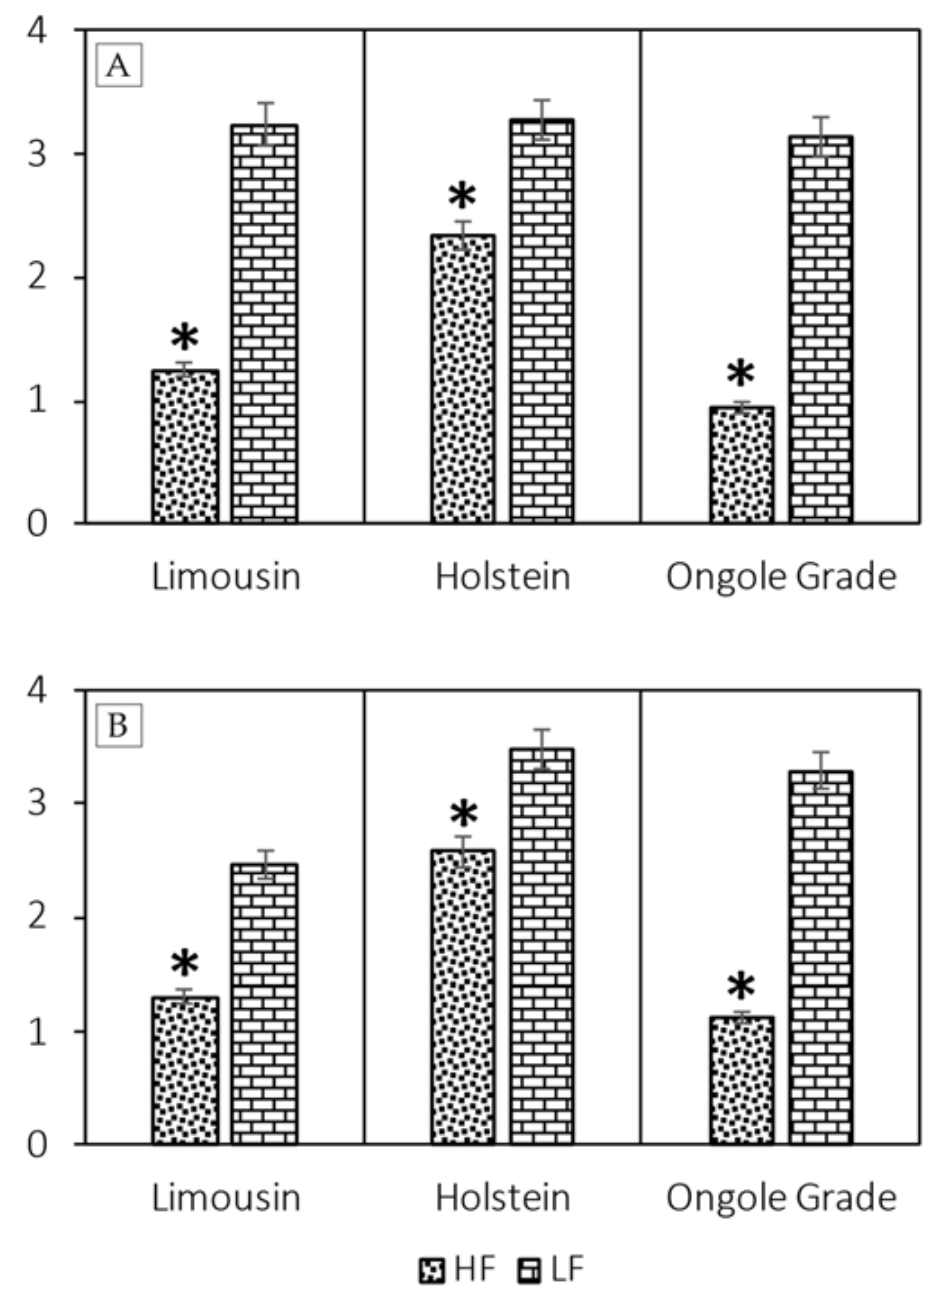
Figure 2. The value of SDF using AO staining ( A ) and Halomax test ( B ) on Limousin, Holstein, and Ongole Grade bulls with different fertility (HF vs. LF). * Significant difference when compared to LF ( p < 0.05).